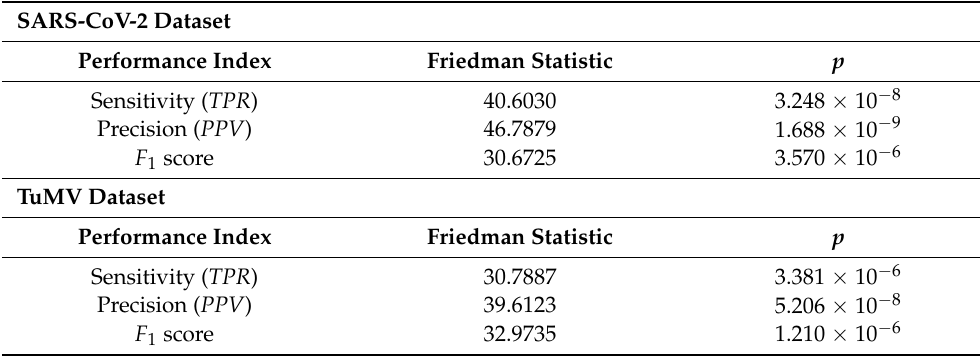
Table 3. Comparation of the five modes in the matched samples (twelve for each dataset) using the Friedmann test. In all the scores and datasets there were significant changes